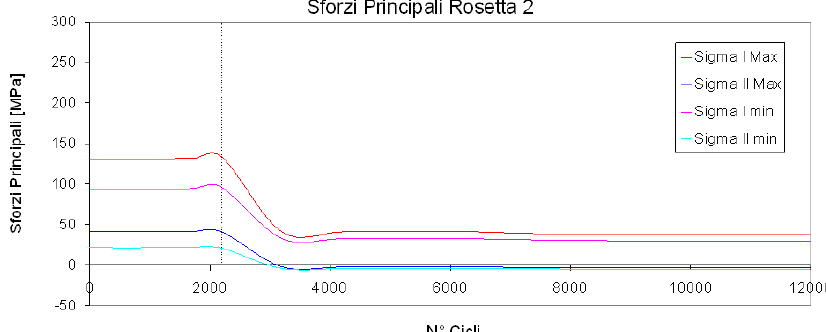
Figura 20: Andamento degli sforzi principali rilevati dalla rosetta 2 in funzione del N° di cicli: le curve di colore rosso/viola e